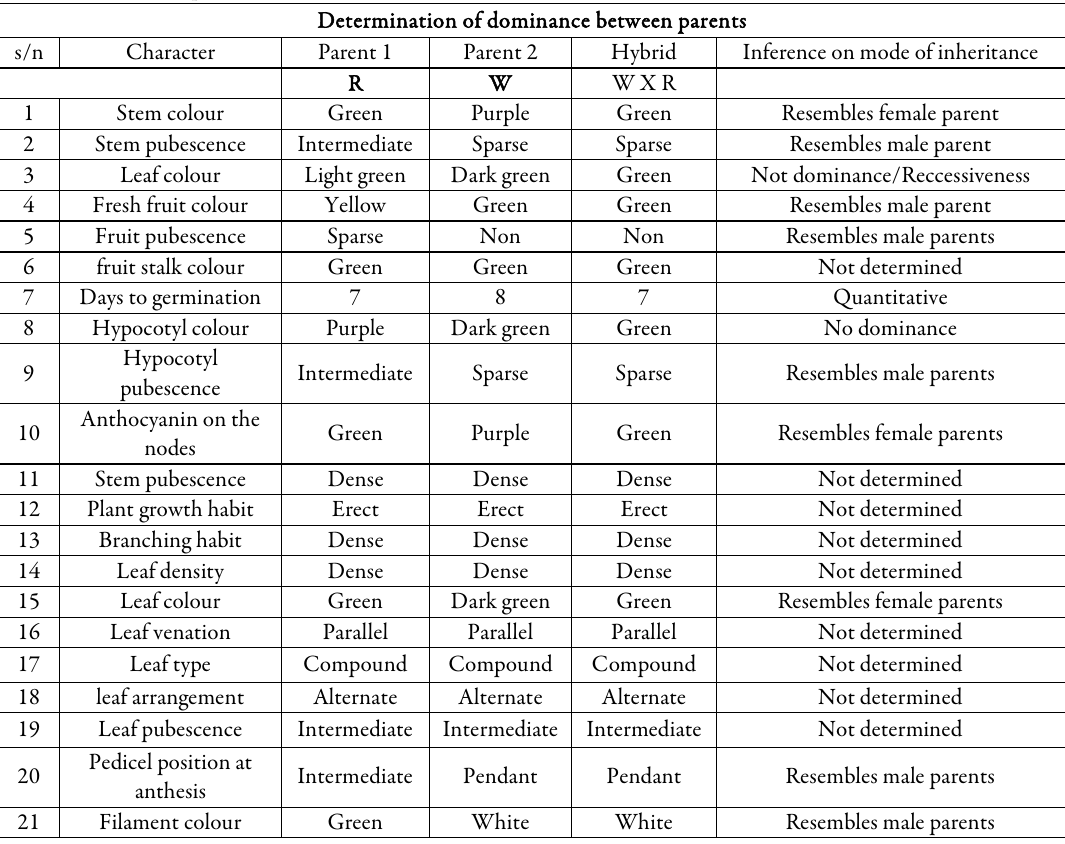
Table 7. Comparison of R and